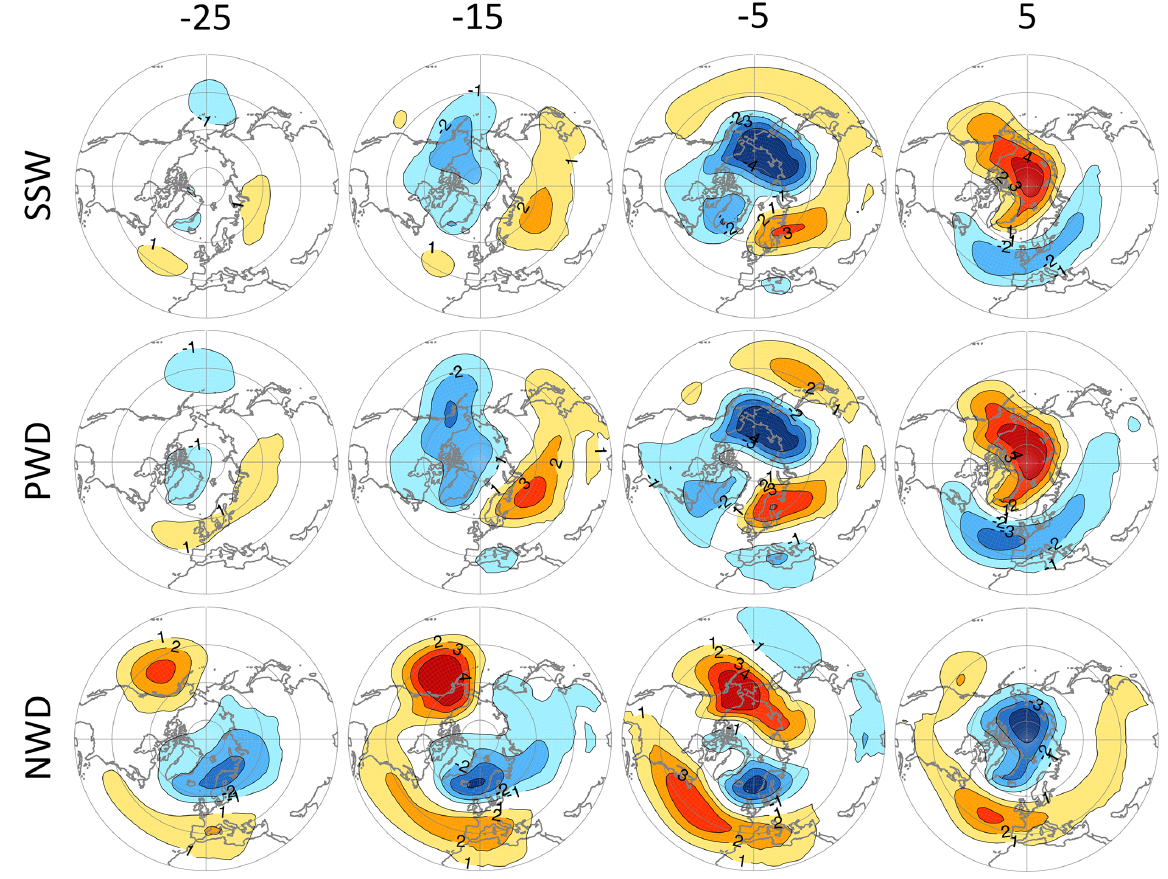
Figure 4. SLP precursors for model-generated (top) SSWs, (middle) PWDs, and (bottom) NWDs during neutral ENSO years. Shown are composite 10d mean SLP anomalies (hPa), centered on the lag days shown on top. Contour interval is 1hPa. Reddish and blueish shadings denote positive and negative anomalies, respectively, which are all statistically significant at the p < 0 . 05 level. The number of SSWs, PWDs, and NWDs is 2607, 2291, and 2172, respectively. The wave driving threshold (cid:80) F (cid:48) is 12.9d. The composite Niño 3.4 index for SSWs, Z crit PWDs, and NWDs is − 0 . 09, 0.04, and − 0 . 24K,